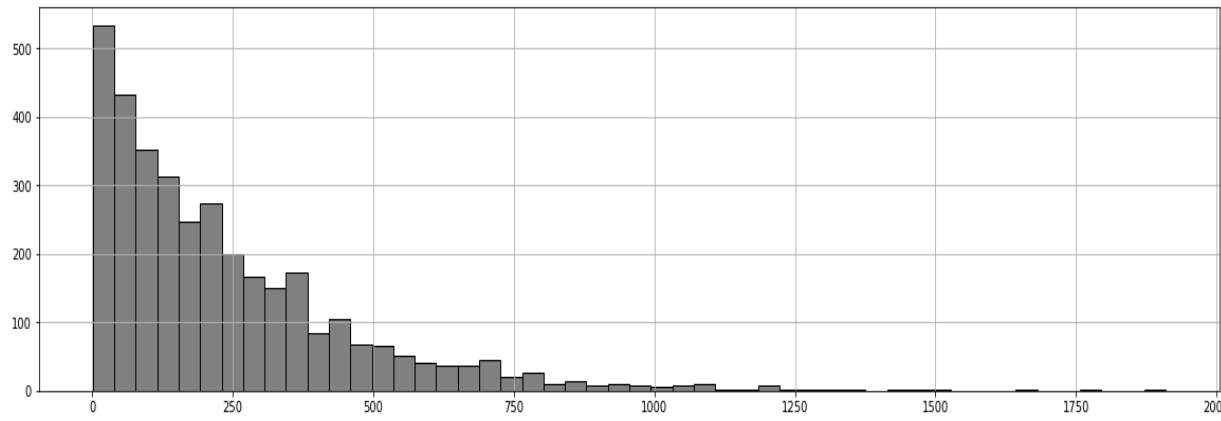
Figure 10. Histogram of elapsed time between errors.